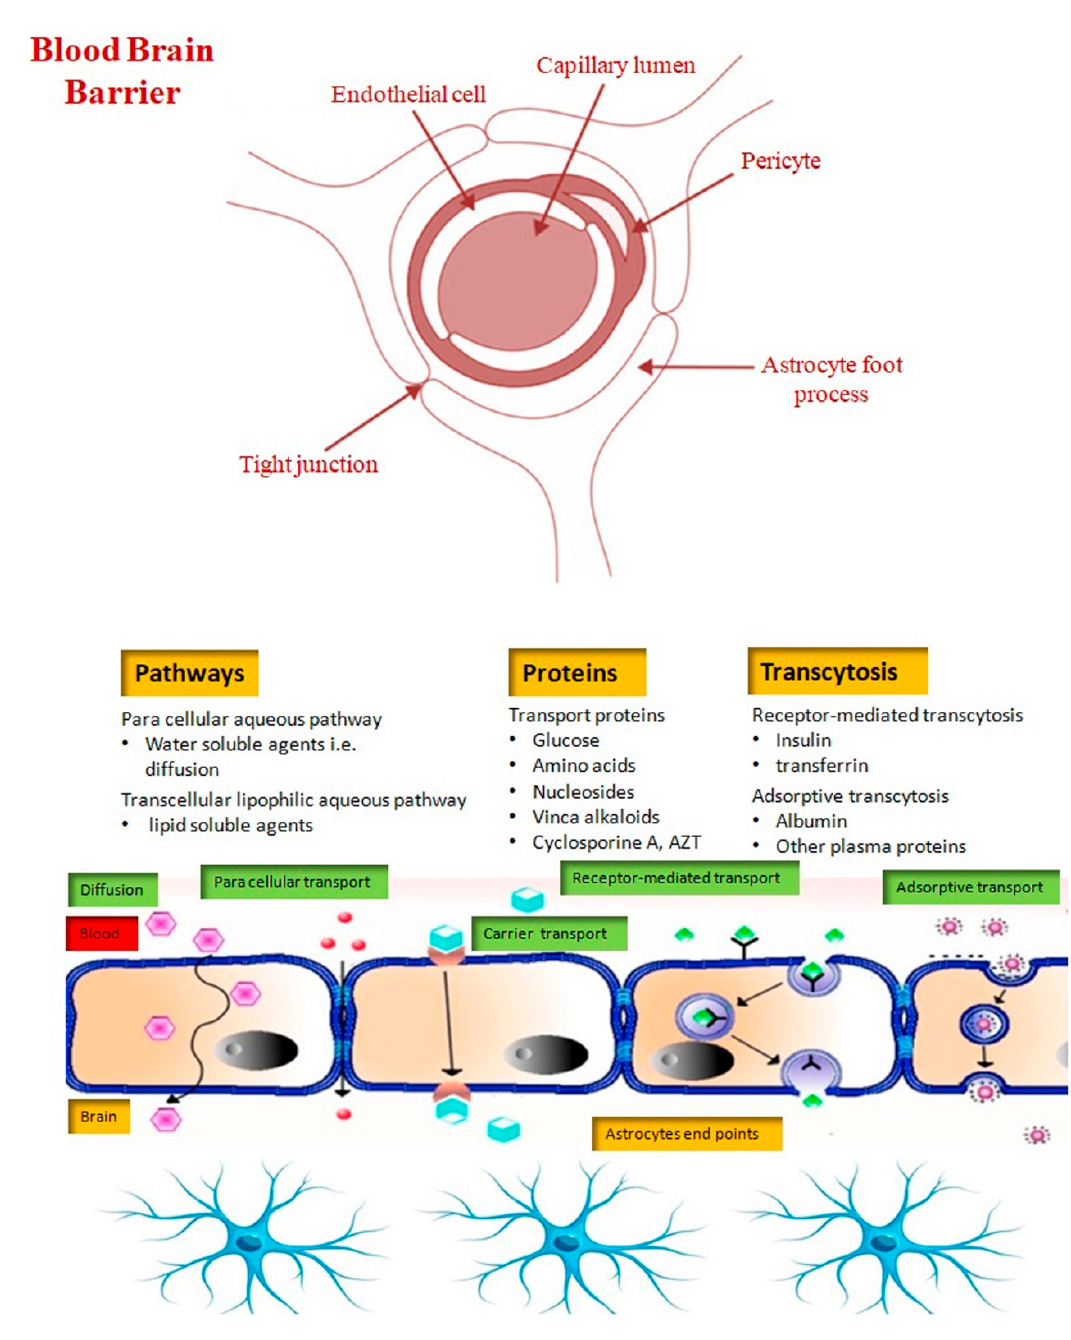
Figure 1. Schematic demonstrating various transport systems that shuttle molecules across the BBB. Very small amount of water-soluble compounds cross through the tight junctions (paracellular), whereas lipid-soluble agents traverse via the transcellular lipophilic pathway. Selective transport systems exist for glucose, amino acids, nucleosides, and other substances, in addition to specific receptor-mediated endocytosis for certain proteins such as insulin and transferrin. (AZT = azathioprine).